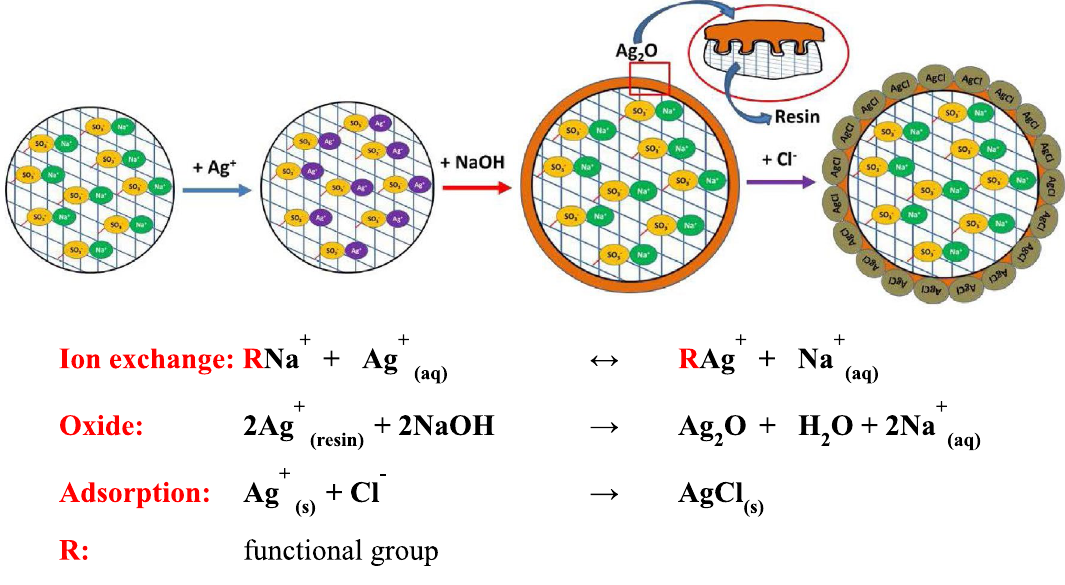
Figure 6. Concept of resin@P-Ag 2 O synthesis and its application for chloride removal.